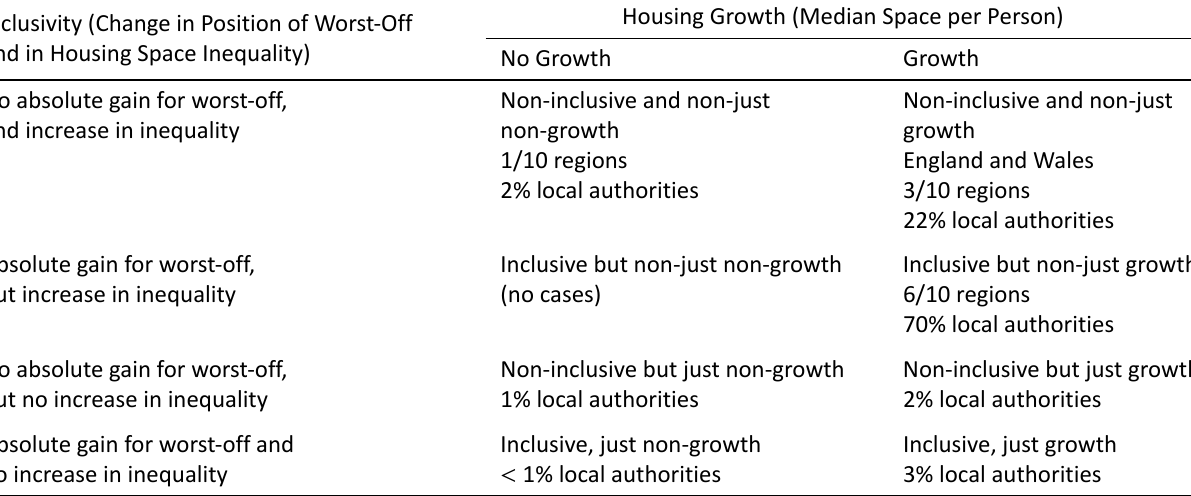
Table 1. Housing growth, inclusivity and justice at national, regional and local authority level,